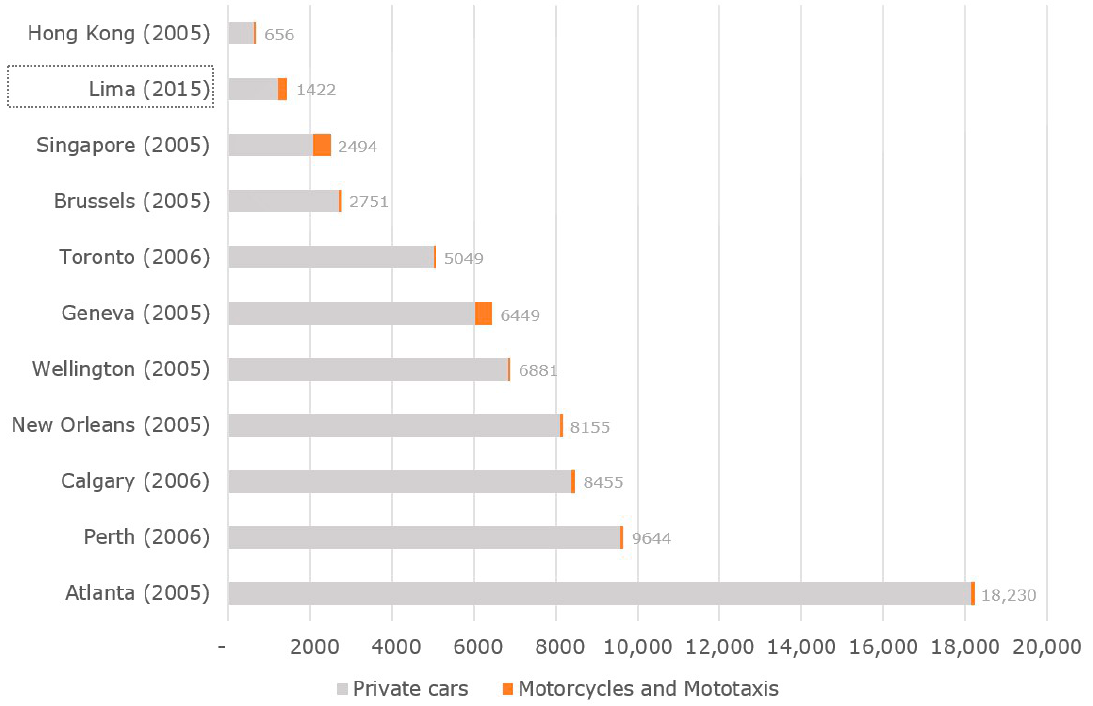
Figure 16. Total private transport vehicle kilometers per capita in world cities (vehicle km/person). Source: References [55,57,63]. Graph by authors.